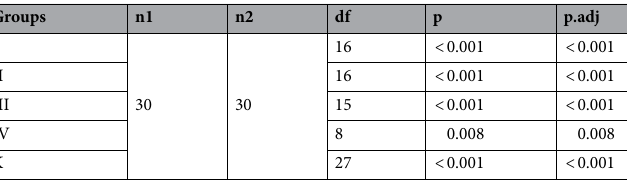
Table 5. Statistical significance for T0, T4 pairwise comparisons within each group by using sign test ( pairwise_sign_test (), { rstatix } package). n1 , n2 sample counts for T0, T4 respectively, df the total number of differences (degrees of freedom), p p-value, p.adj -value adjusted by “holm”